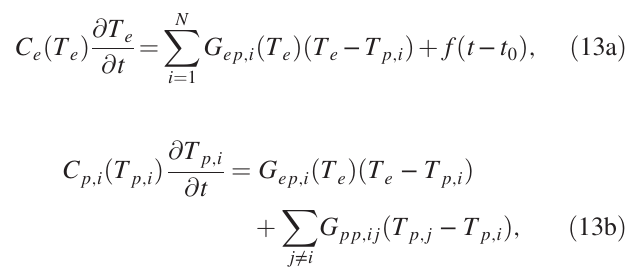
FIG. 4. (a) DFT calculation of the Eliashberg function and its contributions from three phonon branches α 2 F i ¼ TA 1 ; TA 2 ; LA . (b) Lattice heat capacities of the three branches and of the entire lattice in equilibrium as a function of temperature. (c) Electron-phonon coupling calculated for the entire lattice and the individual phonon branches as function of T